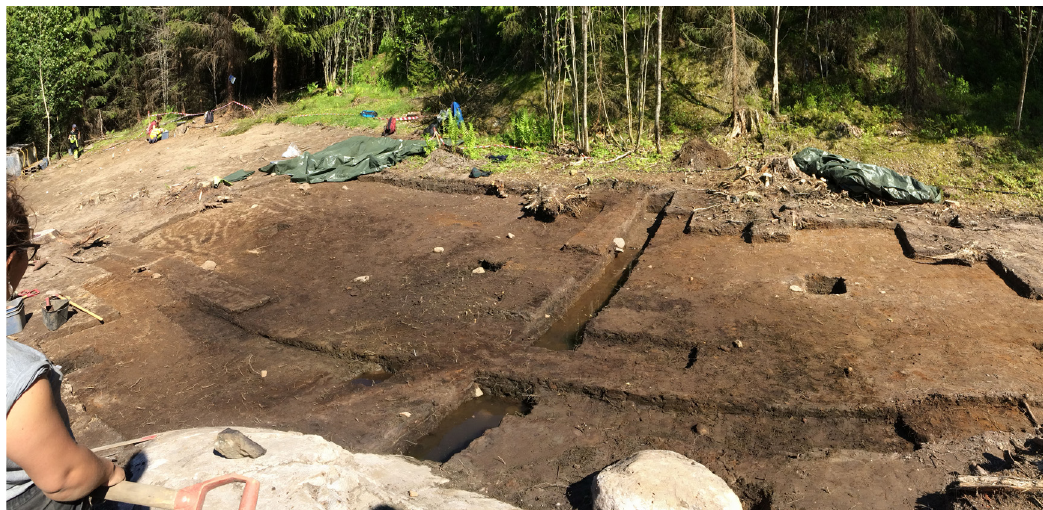
Figure 7: The hut in Havsjødalen. The hut fl oor is seen as an oval, dark layer of cultural deposits measuring approximately 3 m × 6 m. Photo: Carine Eymundsson,